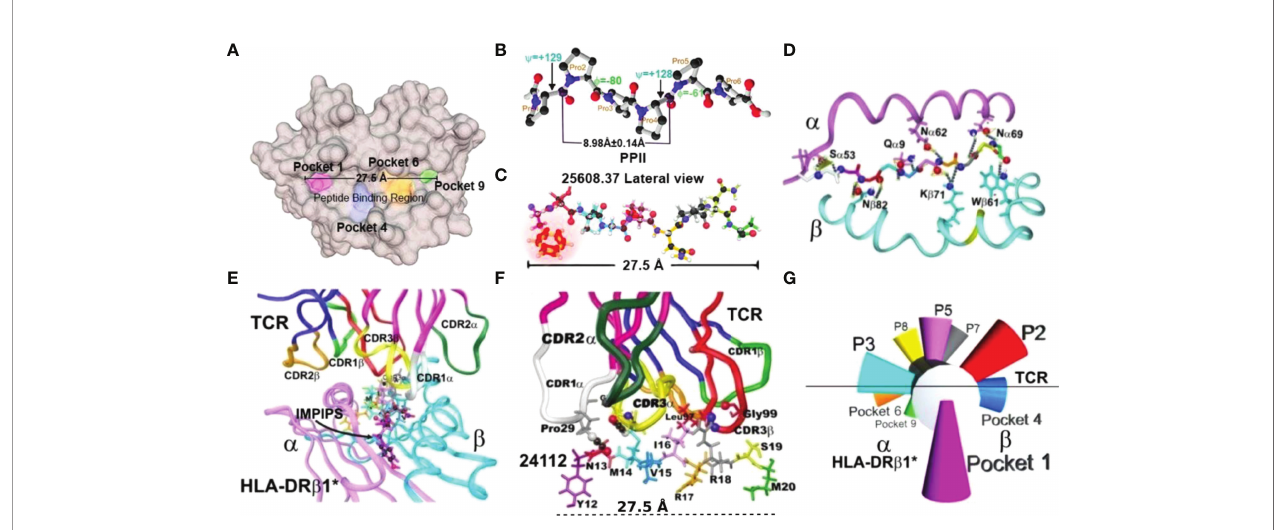
FIGURE 1 | Immune activation system. (A) Top view of the MHCII peptide binding region (PBR), highlighting Pockets 1 (fuchsia), 4 (blue), 6 (orange), and 9 (green) (6, 7). (B) Top view of PPII L 3D structure showing j ( − 80°) and y (+129°) angles and 8.98 ± 0.14 Å distance between every three residues, determined by X-ray crystallography (8). (C) 1 H-NMR-determined malaria peptide 25608 3D structure showing the 27.5 Å distance. The j : − 74.5° ± 14.0° and y : +121.8° ± 18.0° angles in this highly immunogenic peptide fi tted perfectly into the HLA-DR b 1*0401 PBR (9). a - and b -chain aa backbone atoms are shown, emphasising aa side chains establishing H-bonds (silver dots) with malarial peptide 25608 backbone atoms (9). (D) Front view of the HLA-DR b 1*-peptide complex, showing a -chain (deep pink) and b -chain (deep blue). (E) View of the HLA-DR b 1* – peptide – TCR complex, showing TRC a -chain (deep pink) and b -chain (deep blue) with complementary determining regions (CDR) side-chain atoms in ribbon: 1 a (white), 2 a (deep green), 3 a (yellow), 3 b (red), and 1 b (light green) (10). (F) Side-view of TCR-CDR establishing H-bonds with peptide aa side-chain atoms and 27.5Å distance between the most distant atoms fi tting into P1 to P9 (10). (G) Diagram giving a front view of the orientation of peptide side chains fi tting into the HLA-DR b 1*PBR and contacting the TCR to form the HLA-DR b 1* – peptide – TCR